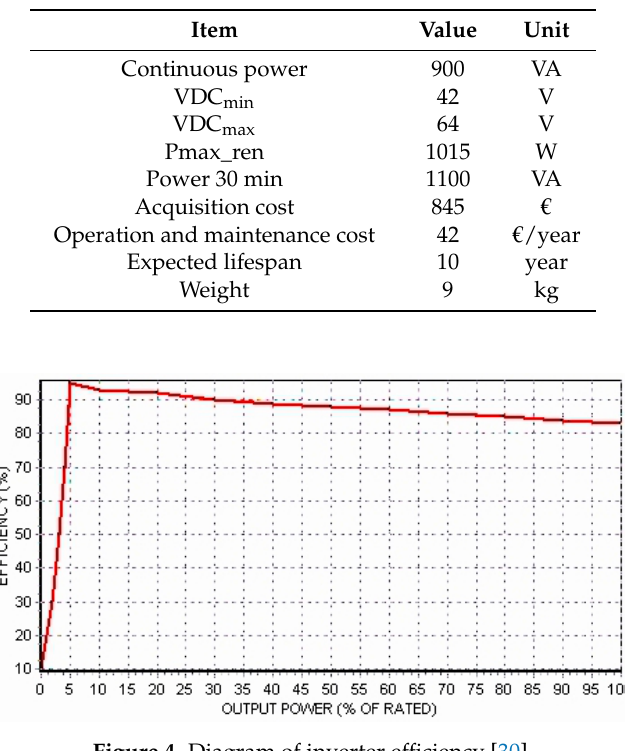
Figure 4. Diagram of inverter efficiency [30].